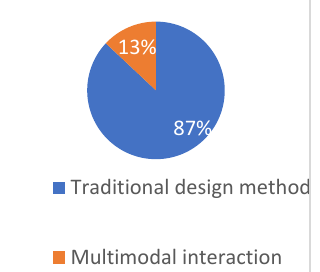
Figure 14. Analysis of preference for design means .